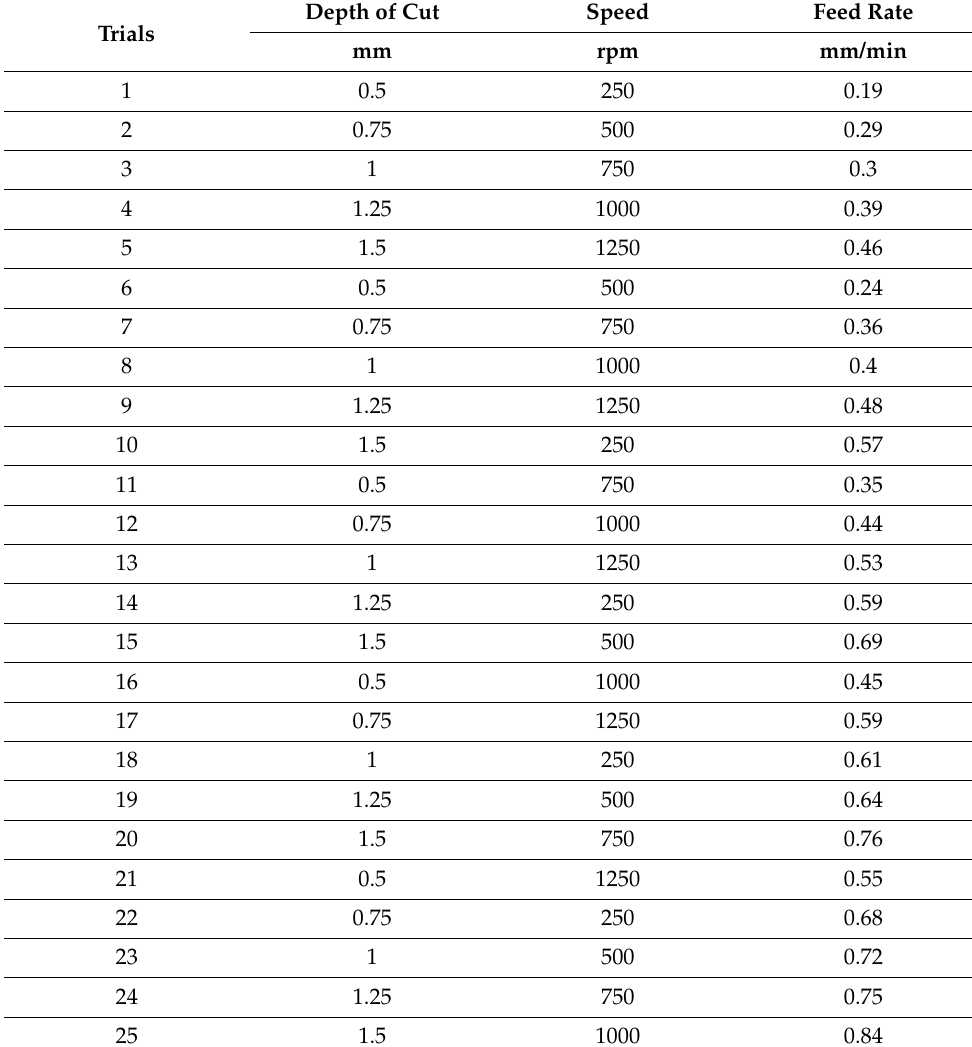
Table 3. Taguchi L25 orthogonal array—Combination of machining